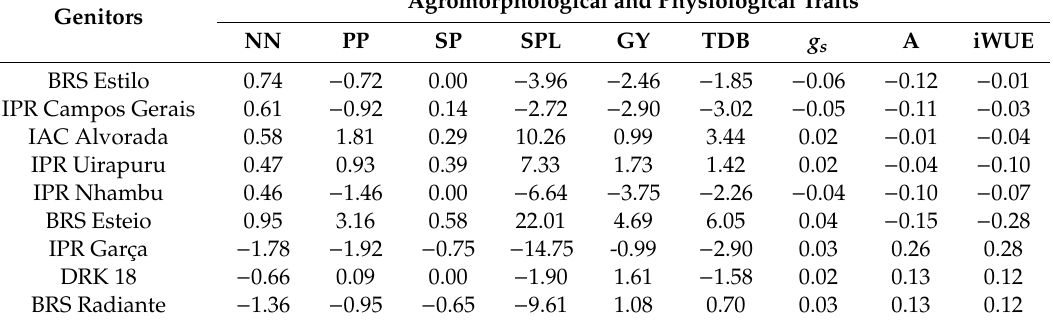
Table 4. Estimates of general combining ability ( ˆ g i ) e ff ects evaluated for genotypes of group II subjected to water deficit.